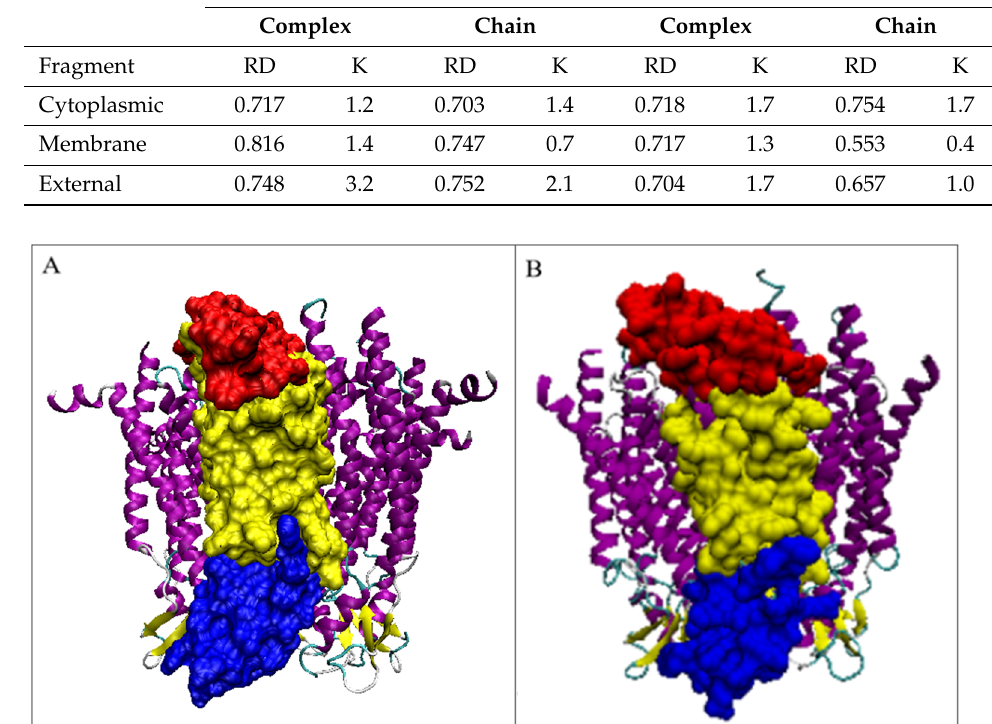
Figure 9. 3D presentation: ( A )—pannexin; ( B )—connexin with highlighted parts: the part facing the cytoplasm—red, the part anchored in the membrane—yellow, the part facing the outside of the cell—blue marine. Violet chains—adjacent chains to visualize the mutual orientation of adjacent chains. This status is given in Table 3. Table 3. The status of the complex part and the single chain is defined as cytoplasmic—the extra- membrane part facing the cytoplasm of the cell, membrane—part anchored to the membrane; exter- nal—the part exposed outside the cell.